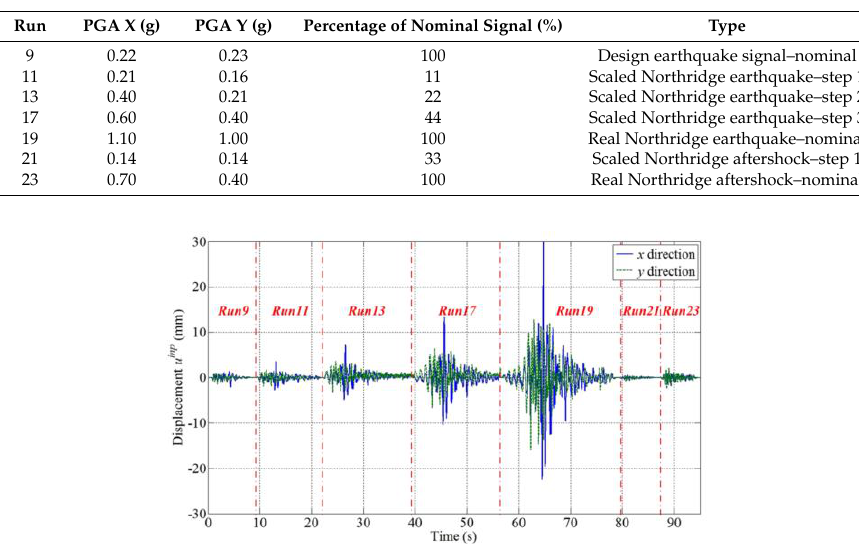
Table 8. Nominal input ground motions for a nonlinear seismic analysis.